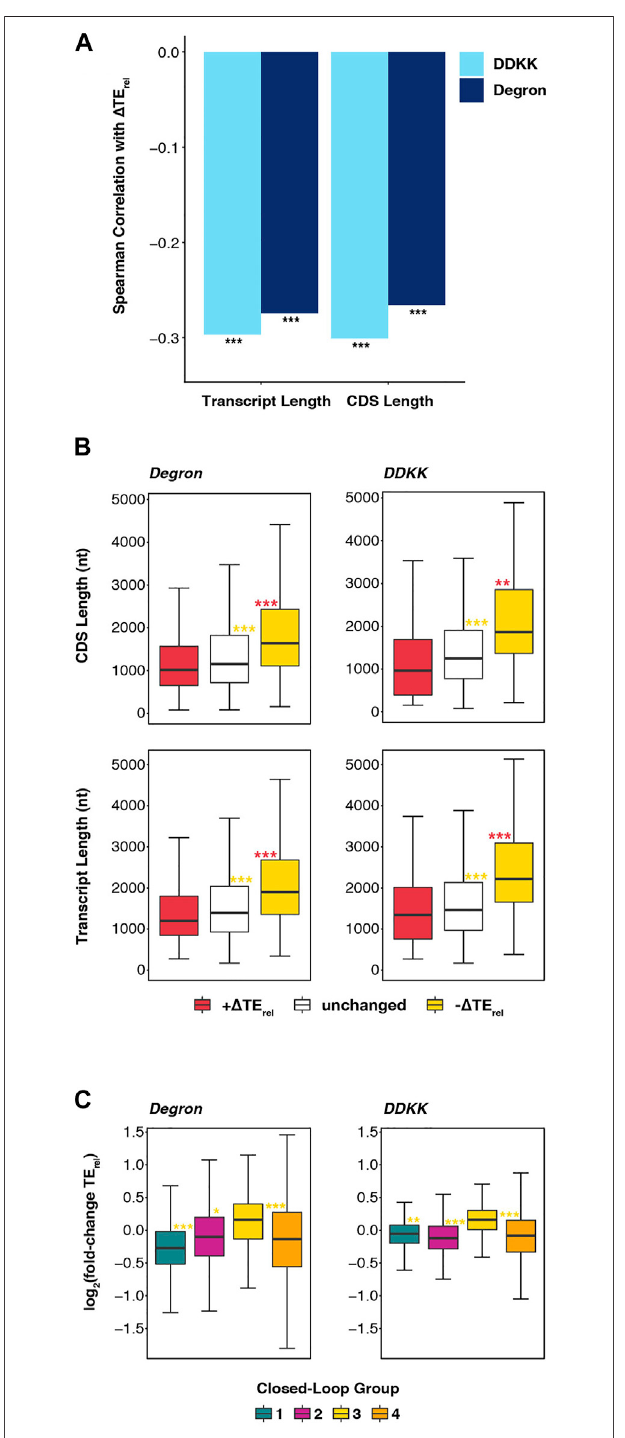
FIGURE 5 | Disruption of the eIF3 complex or its mRNA-entry- channel arm most strongly affect long mRNAs with a weaker dependence on closed loop formation. (A) Bar plot showing Spearman correlation coef fi cients obtained when comparing Δ TE rel values observed in eIF3a/b Degron (dark blue) or eIF3i DDKK (light blue) cells with overall transcript length and CDS length *** (cid:1) P < 10 − 10 , ** (cid:1) P < 10 − 5 , * (cid:1) P <